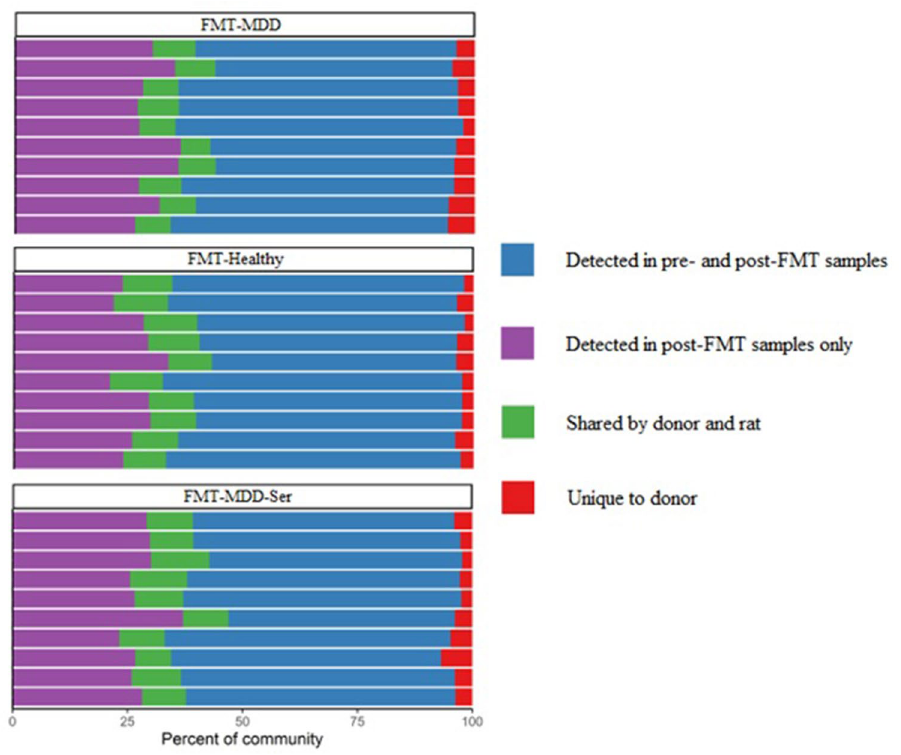
Figure 2. Stacked bar plots of relative changes in gut microbiota composition of FRL rats. Each bar represents all the OTUs observed across samples from one rat. OTUs in blue were detected in both pre-and post-FMT samples, while OTUs in purple were novel in the rat and not detected in the donor material. The green OTUs were common in both rats and humans, while the red percentage was unique to the human donor material only. FMT-MDD: Faecal microbiota transplantation from patients with MDD into rats. FMT-Healthy: Faecal microbiota transplantation from healthy individuals into rats. FMT-MDD-Ser: Faecal microbiota transplantation from patients with MDD into rats combined with treatment with